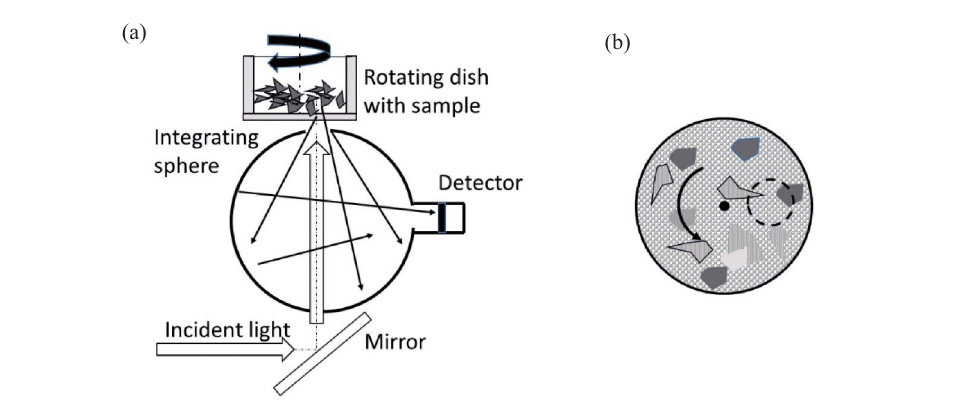
Fig. 1. (a) sample illumination and collection of reflected light; (b) top view of Petri dish; dashed line indicates the area of incident light